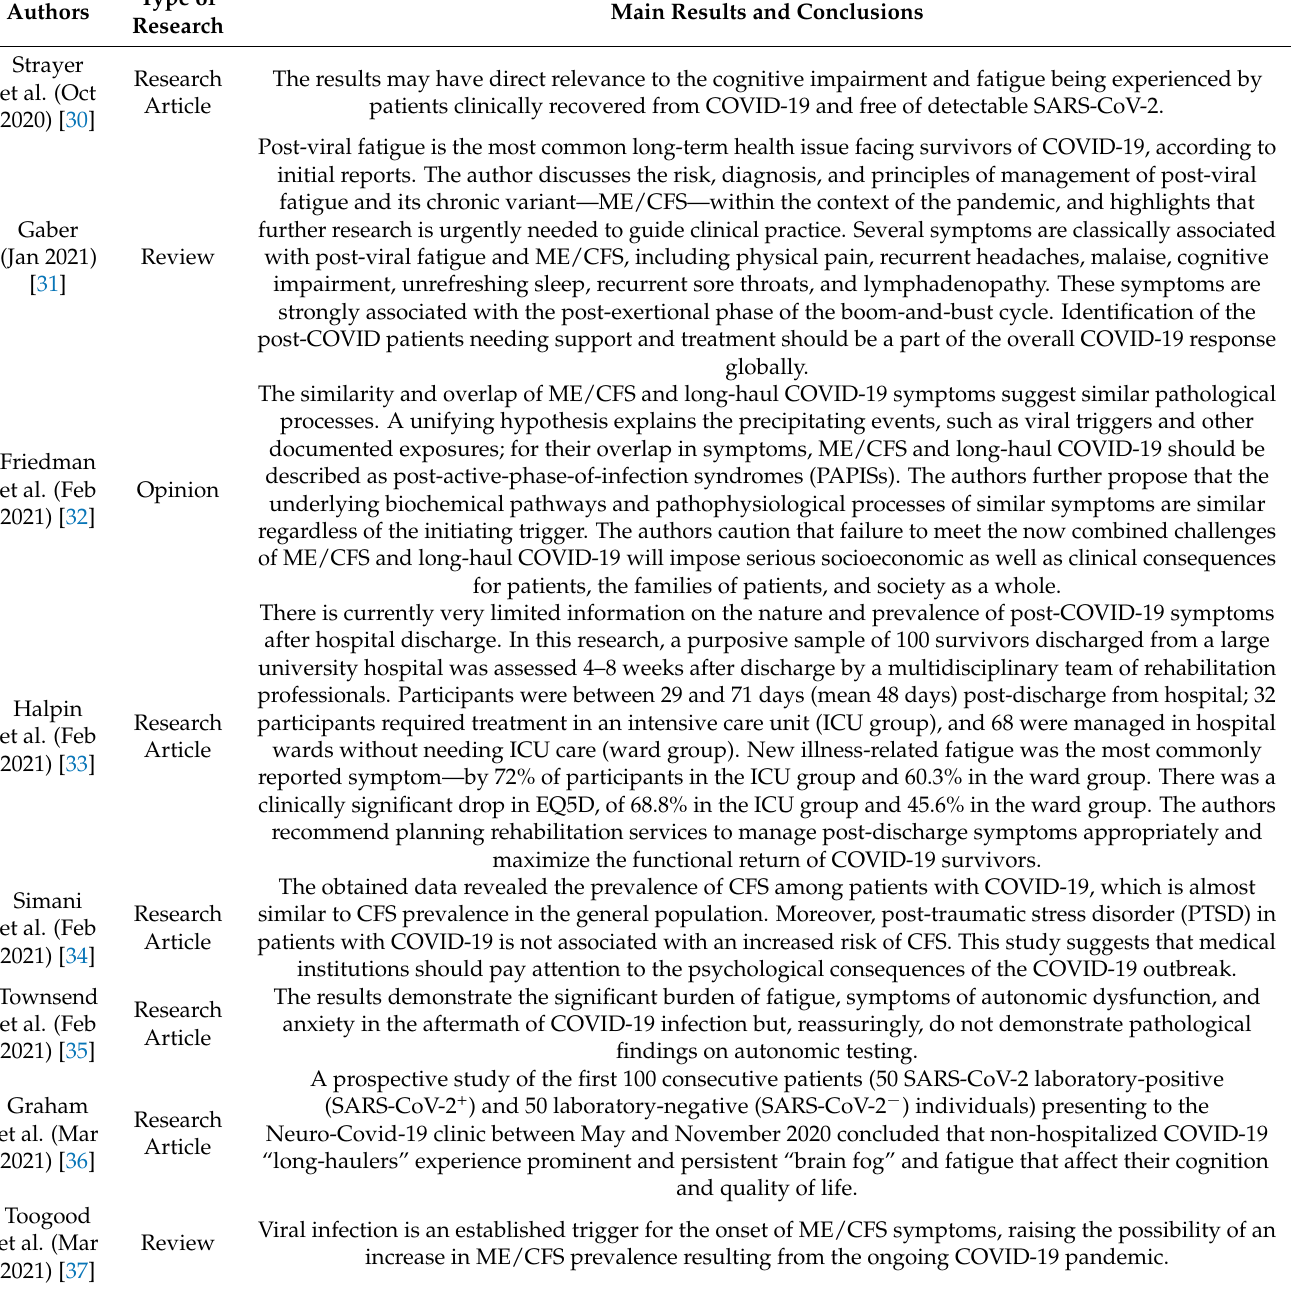
Table 1. Characteristics of the scientific articles included in our analysis to assess the possible interaction between ME/CFS and